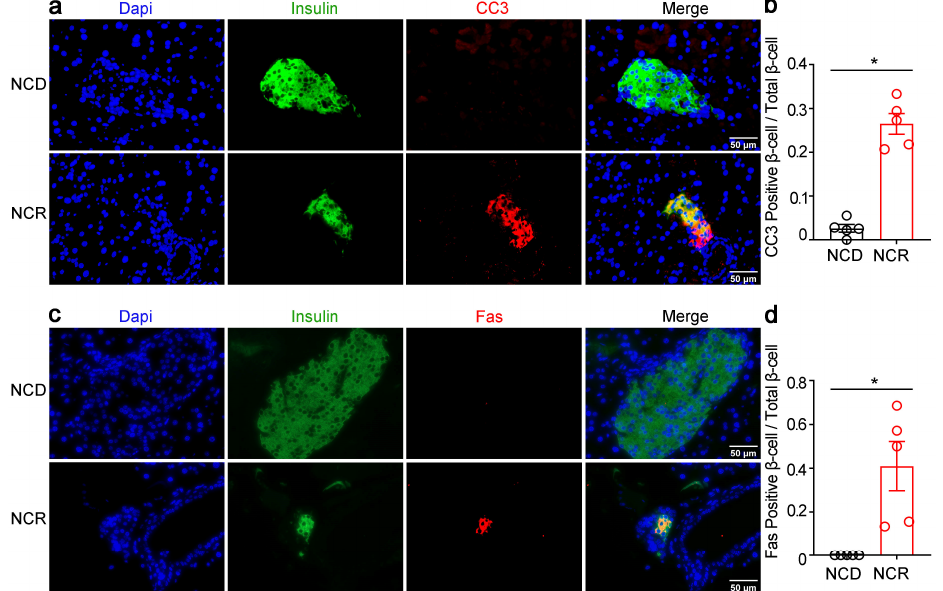
Figure 2. CR stimulated β -cell apoptosis in normal chow diet-fed mice. ( a , c ) Representative im- Figure 2. CR stimulated β‐ cell apoptosis in normal chow diet ‐ fed mice. ( a , c ) Representative immu ‐ munofluorescence images of cleaved caspase-3 (CC3, red), death receptor Fas/CD95 (Fas, red), nofluorescence images of cleaved caspase ‐ 3 (CC3, red), death receptor Fas/CD95 (Fas, red), and in ‐ and insulin (green). ( b ) Quantification of CC3-positive β -cells/total β -cells ( β -cell apoptosis fre- sulin (green). ( b ) Quantification of CC3 ‐ positive β‐ cells/total β‐ cells ( β‐ cell apoptosis frequency). ( d ) Quantification of Fas ‐ positive β‐ cells/total β‐ cells. The results were expressed as mean values ± SEM. quency). ( d ) Quantification of Fas-positive β -cells/total β -cells. The results were expressed as (Five mice per group) * p < 0.05 vs. NCD mice. mean values ± SEM. (Five mice per group) * p < 0.05 vs. NCD Previous studies reported that excessive exposure of β‐ cell to FFA impaired β‐ cell function and induced β‐ cell apoptosis. Therefore, we examined the lipid synthesis path ‐ way in the NCD and NCR groups. Immunofluorescence staining showed that the fatty acid synthase (FASN) signal was increased in the β‐ cells of NCR mice (Figure 3a,b). Ex ‐ pression levels of lipogenic transcription factors such as SREBP1c and PPAR γ and en ‐ zymes of lipid synthesis such as FASN and ACC were significantly upregulated in the NCR group (Figure 3a–d). Consistent with the upregulation of the lipid synthesis path ‐ way, increased pancreatic triglyceride content was detected in NCR mice (Figure 3e).